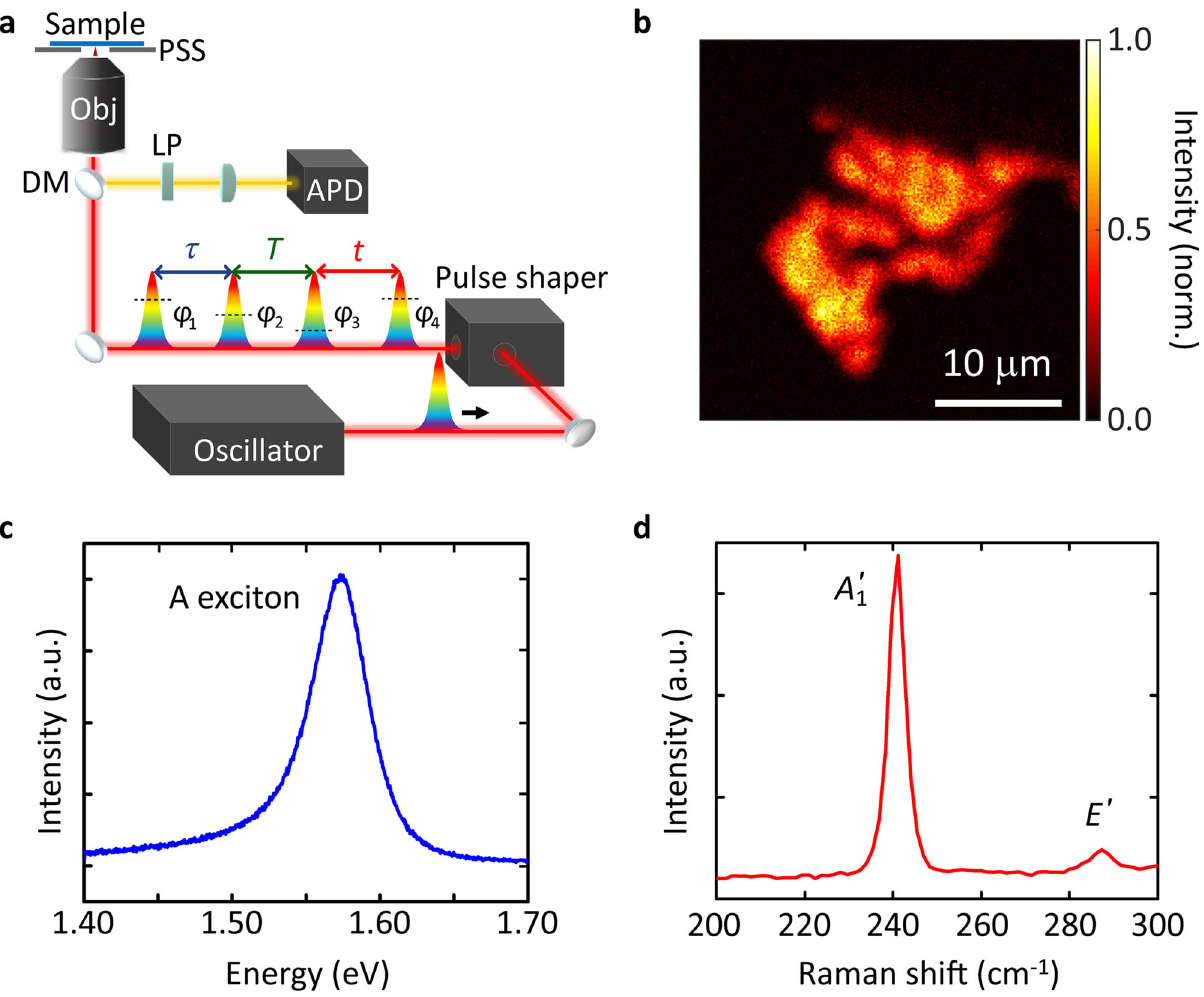
Fig. 1 Overview of setup and the sample. a Fluorescence-detected 2d micro-spectroscopy setup. Four collinear laser pulses are generated by a pulse shaper with controllable inter-pulse time delays ( τ , T , t ) and phases ( φ i , i = 1, 2, 3, 4) and focused by a high-NA objective (Obj). The position of the sample is controlled by a piezo scanning stage (PSS). The dichroic mirror (DM) under the objective transmits the excitation beam (red) and re fl ects the PL signal (yellow). A long-pass fi lter (LP) is used to block the remaining excitation beam. The PL signal is detected by an avalanche photodiode (APD). b PL map obtained with the setup of panel a . c PL and d Raman spectrum for 514 nm excitation. The peak in the PL spectrum corresponds to the A exciton. The Raman spectrum shows the out-of-plane A ′ 1 mode ~ 241 cm − 1 , and the in-plane E ′ mode ~ 288 cm − 1